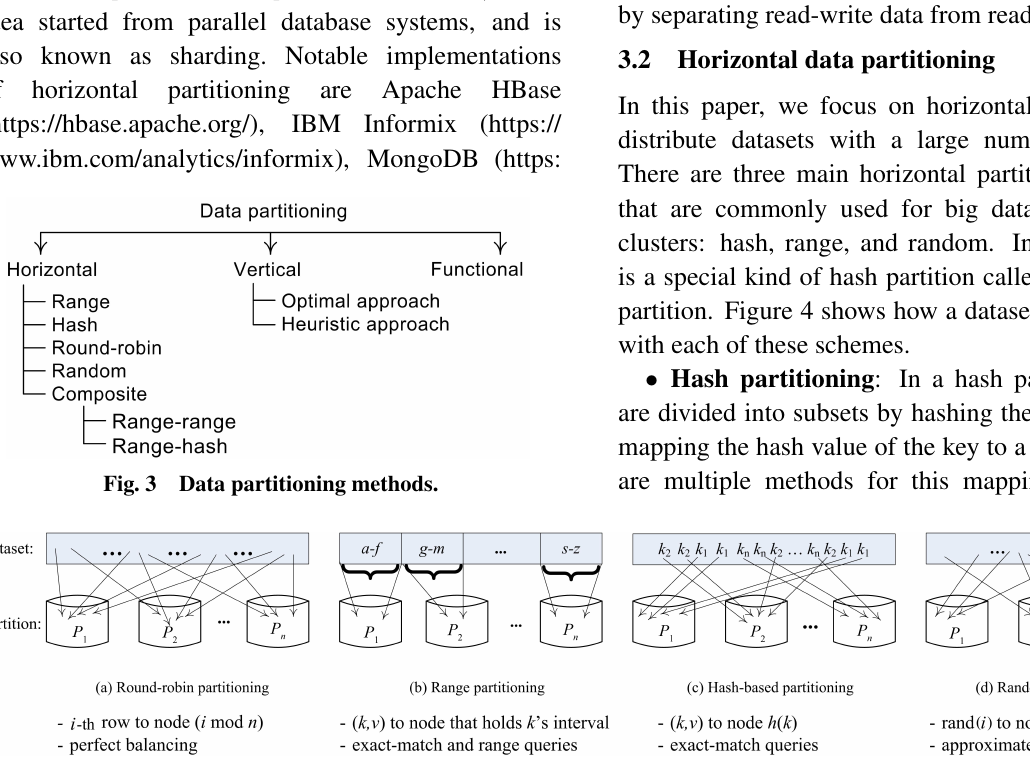
Fig. 4 Horizontal partitioning